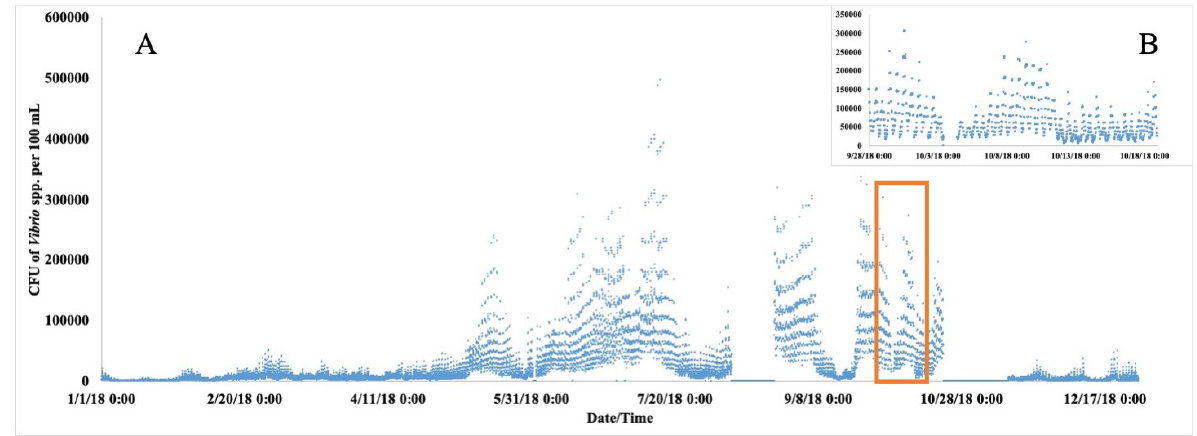
Figure A1. Calculated Vibrio spp. concentrations for site 021720709 CFUs/100 mL for 2018 including Hurricane Florence (top right corner inset, ( B )). ( A ) Calculated Vibrio spp. concentrations (in CFUs) for site 021720709 for all of 2018. Each point represents a 15-min detection window. ( B ) Calculated Vibrio spp. concentrations (in CFUs) for site 021720709 for the period during and after Hurricane Florence. The time window for ( B ) is indicated in ( A ) by the red box.